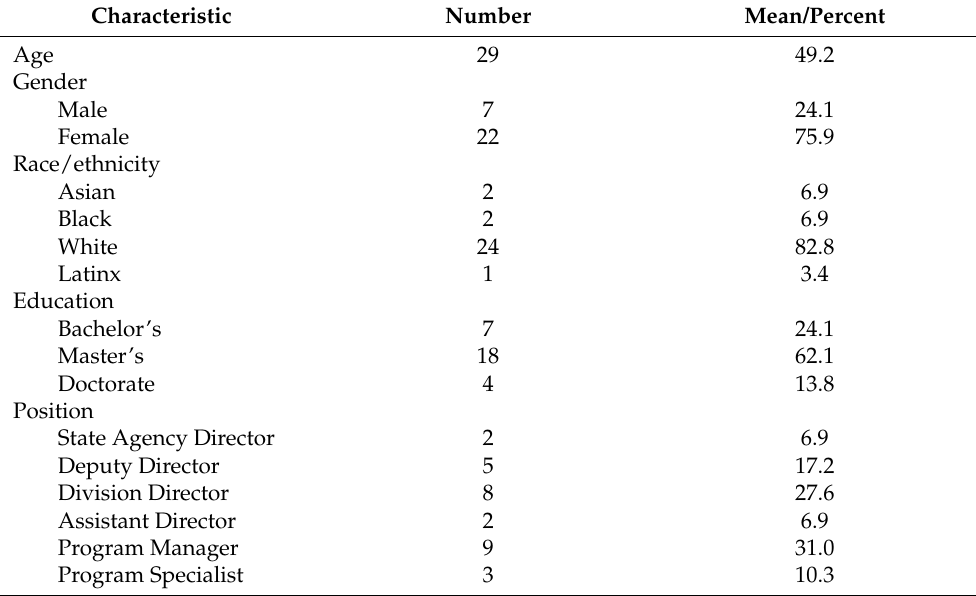
Table 1. Demographic characteristics of study